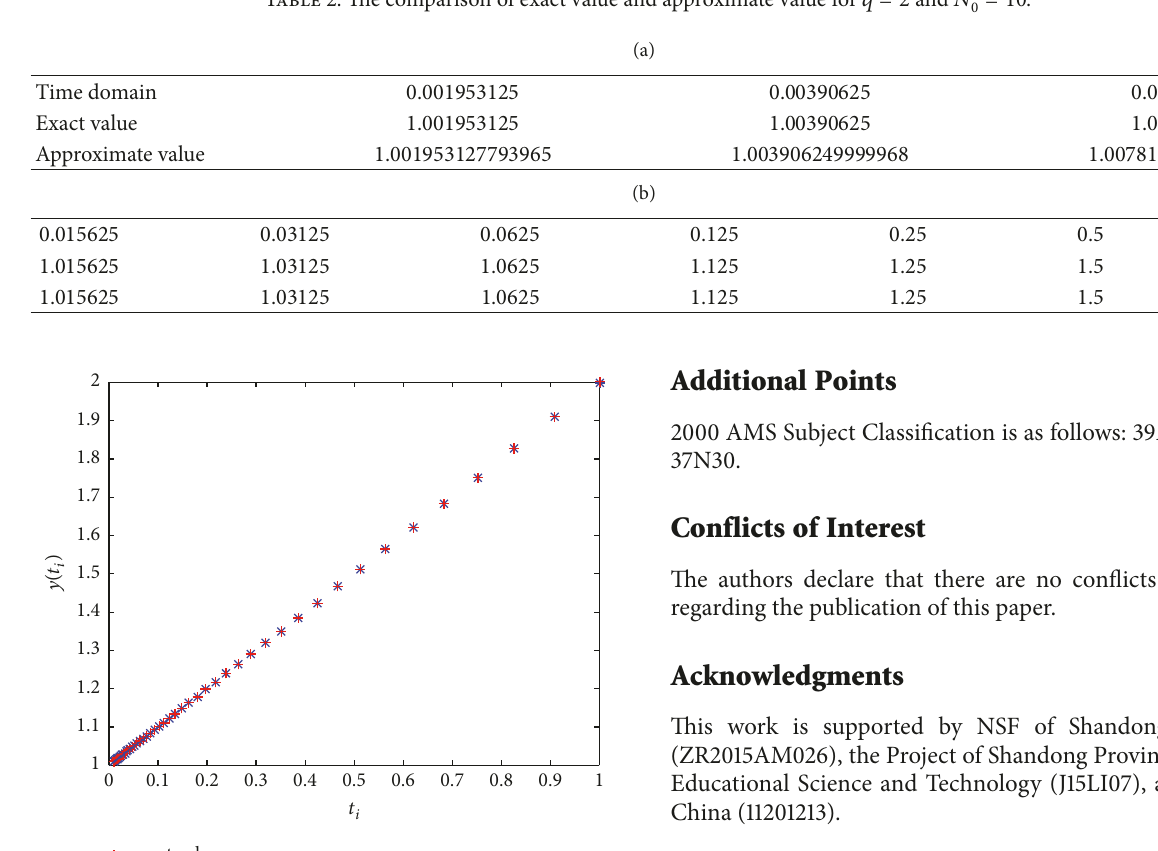
Table 2: The comparison of exact value and approximate value for 𝑞 = 2 and 𝑁 0 = 10.